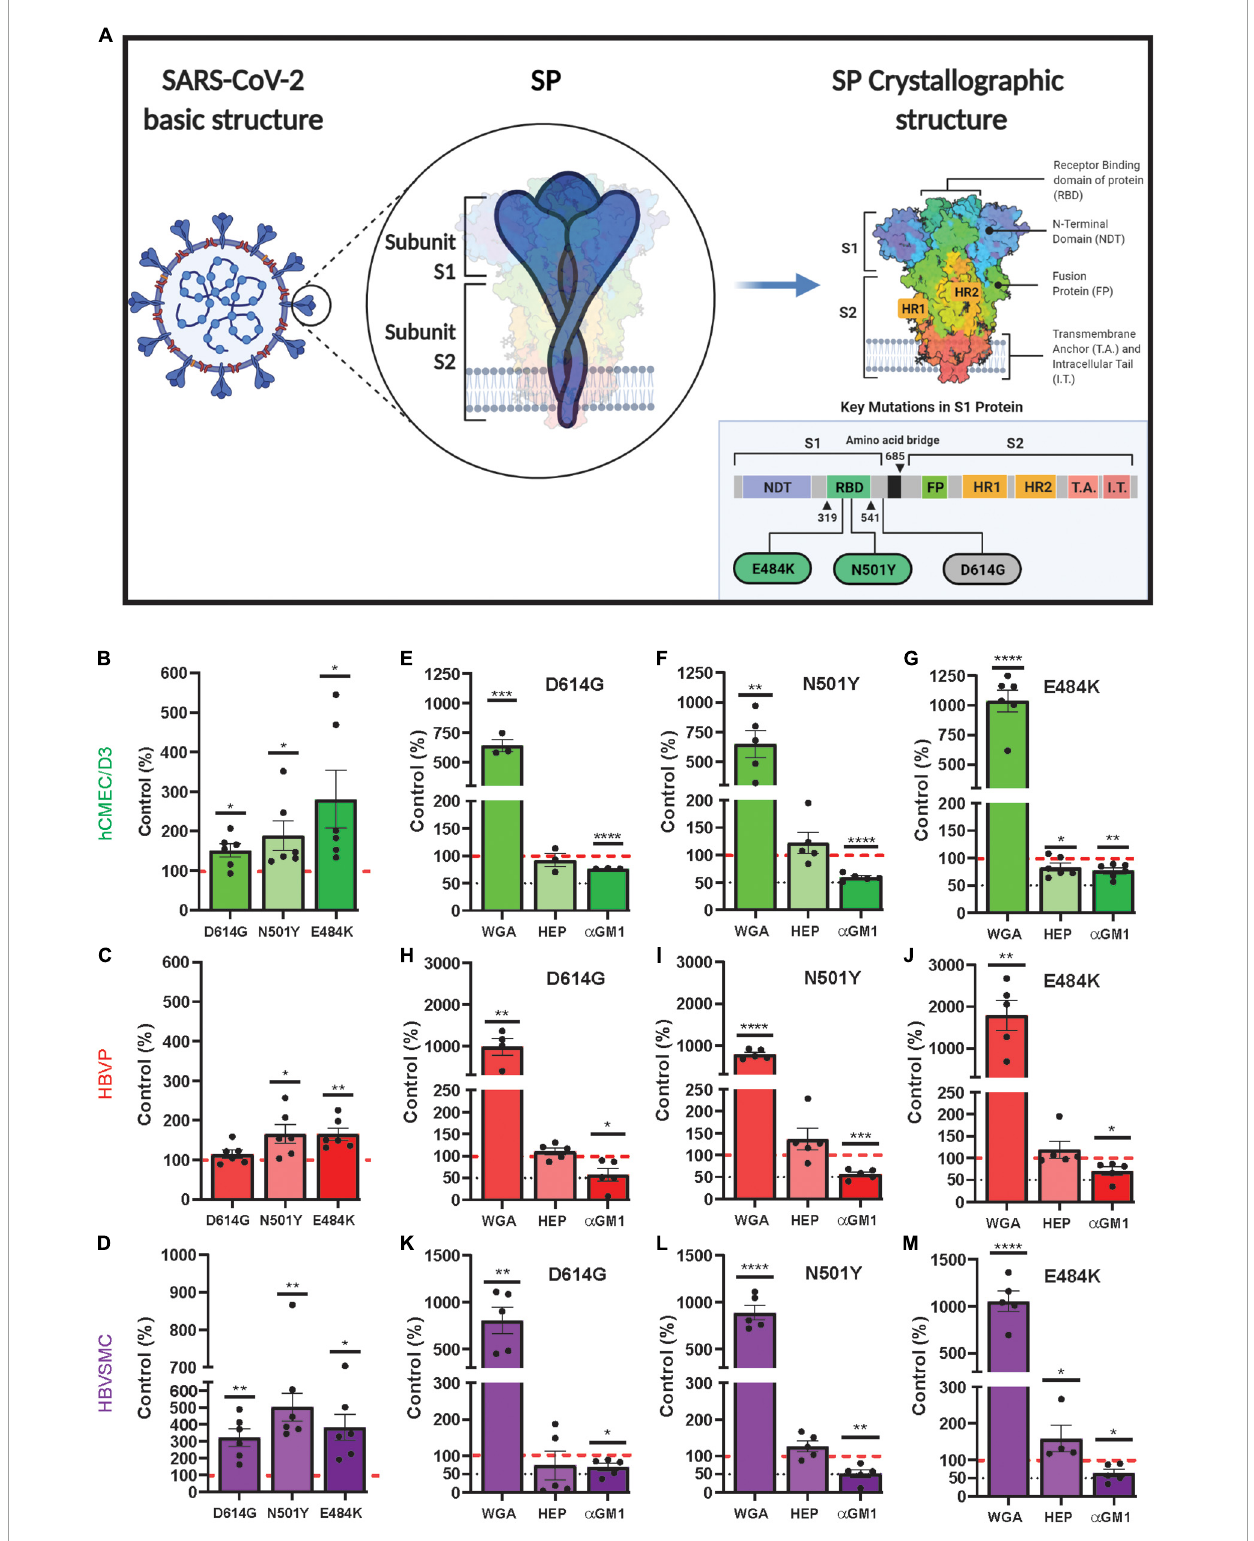
FIGURE5 Increased mutant SARS-CoV-2/SP uptake by cerebrovascular cells. (A) Schematic diagram showing the mutation sites of the three mutants (D614G, N501Y and E484K) used in this study. Adapted from “An In-depth look into the Structure of the SARS-CoV2 Spike Glycoprotein,” by (2021). Retrieved from https://app.biorender.com/biorender-templates. (B–D) Mutant SP-555 uptake compared to control wild-type SP (red dashed line) for hCMEC/D3 (B) , HBVP (C) , and HBVSMC (D) . (E–M) The effects of wheat germ agglutinin (WGA), heparin and anti GM1 (a mono sialic acid ganglioside) on the three cell types, hCMEC/D3 (E–G) , HBVP (H–J) , and HBVSMC (K–M) . Controls are the SARS-CoV-2/SP uptake without the test compounds. Values are mean ± SEM. N = data points (wells) shown with the histogram. Red dashed line is the control levels (100%). Supplementary Figure 6